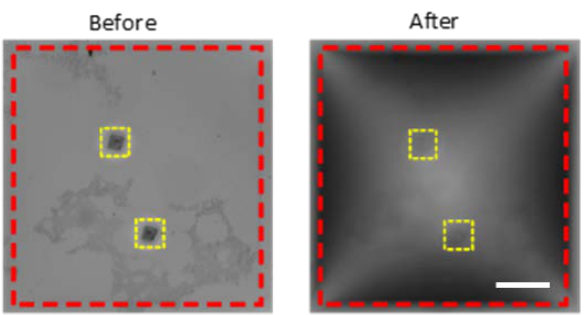
Figure 5. Membrane deflection before and after the application of a pressure of 20 psi. Scale bar represents 100 µm.